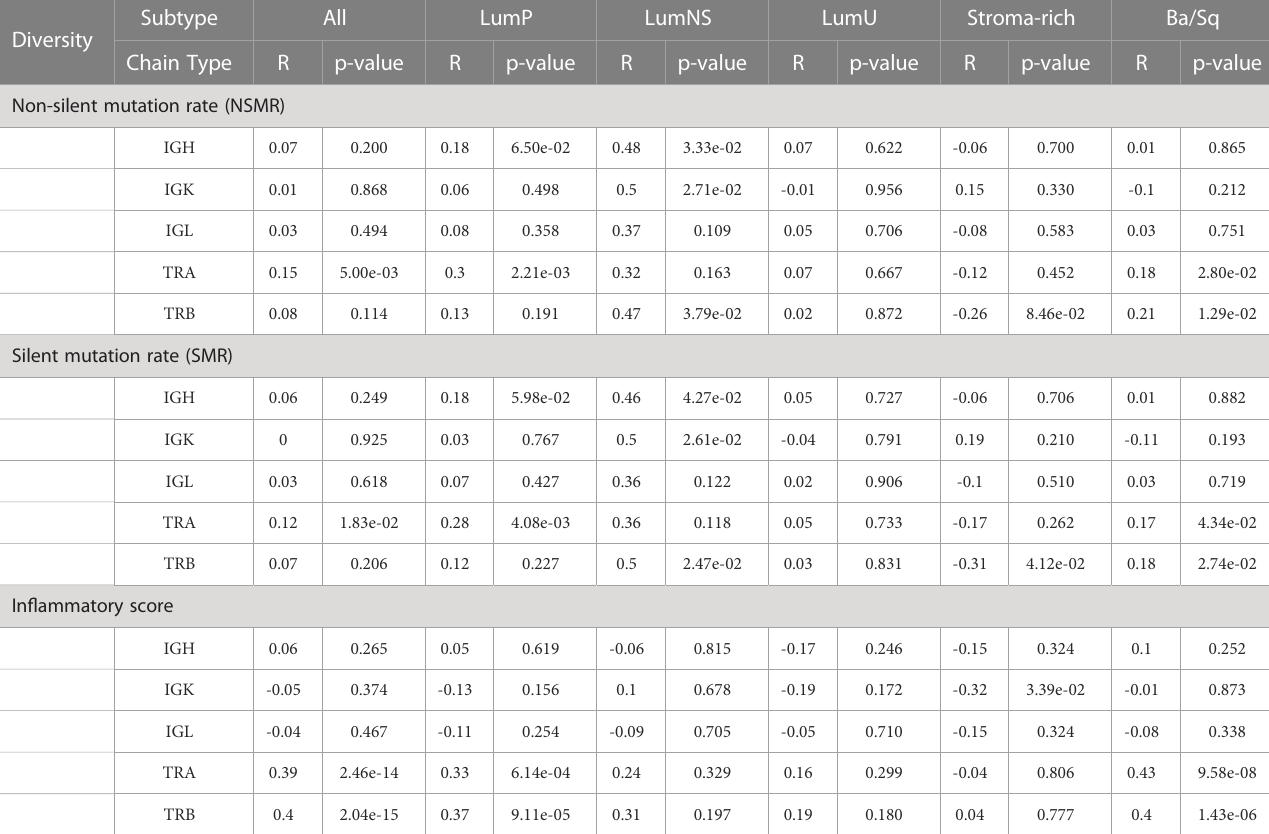
TABLE 3 Correlation between the two mutational rates and in fl ammatory score and diversity for all receptors by subtypes.